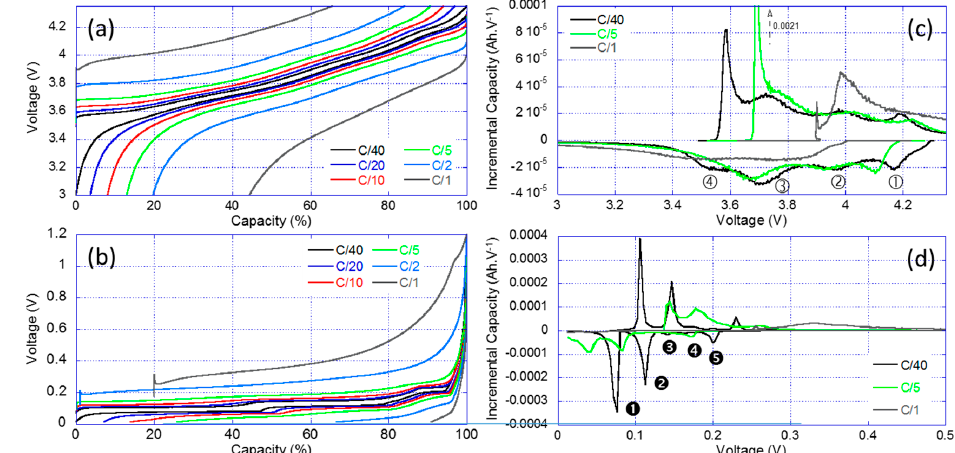
Figure 4. Reference performance test (RPT) results for the half-cell testing: ( a ) voltage vs. normalized capacity curves; ( b ) associated IC signature for the positive electrode (PE); ( c ) voltage vs. capacity curves; and ( d ) associated IC signature for the negative electrode (NE).